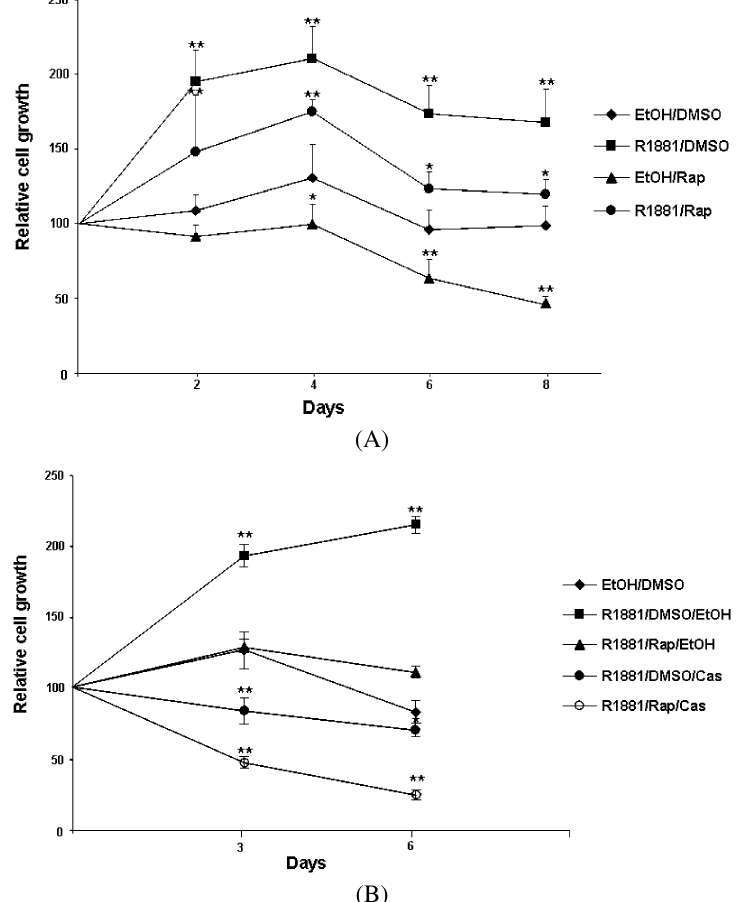
Fig. 5. Effect of mTOR inhibition and antiandrogen treatment on growth of LNCaP cells. (A) mTOR inhibition overrides androgen-induced growth of LNCaP cells. LNCaP cells were grown in 6-well plates as described in Materials and Methods. Cells were treated with either ethanol or DMSO (diamonds), R1881 (10 − 8 M) and DMSO (squares), ethanol and rapamycin (100 nM) (triangles), or R1881 (10 − 8 M) and rapamycin (100 nM) (circle) for eight days. Cells were then counted in a haemocytometer in duplicate. The average number of cells for each experiment was set to 100 at day 0. Data represent the relative mean cell numbers from three independent experiments done in triplicate with error bars shown as ± SEM. The significance between vehicle and each respective treatment was calculated by one-tailed, paired Student’s t -test; asterisk: P < 0 . 05; double asterisk: P < 0 . 01. (B) Potentiation of rapamycin-induced inhibition of LNCaP cell growth by bicalutamide. LNCaP cells were grown in 6-well plates as described in Section 2. Cells were treated with either ethanol or DMSO (diamonds), R1881 (10 − 10 M), DMSO and ethanol (squares), R1881, rapamycin (100 nM) and ethanol (triangles), R1881, DMSO and casodex (100 µM) (circle), or R1881, rapamycin, and casodex (open circle) for three and six days. Viable cells were then counted in a haemocytometer in duplicate. The average number of live cells for each experiment was set to 100 at day 0. Data represent the relative mean cell numbers from one representative experiment done in triplicate, with error bars shown as ± SEM. The experiment was repeated twice with similar results. The significance between R1881 and rapamycin-treated samples and each respective treatment was calculated by one-tailed, paired Student’s t -test; asterisk: P < 0 . 05; double asterisk: P < 0 .